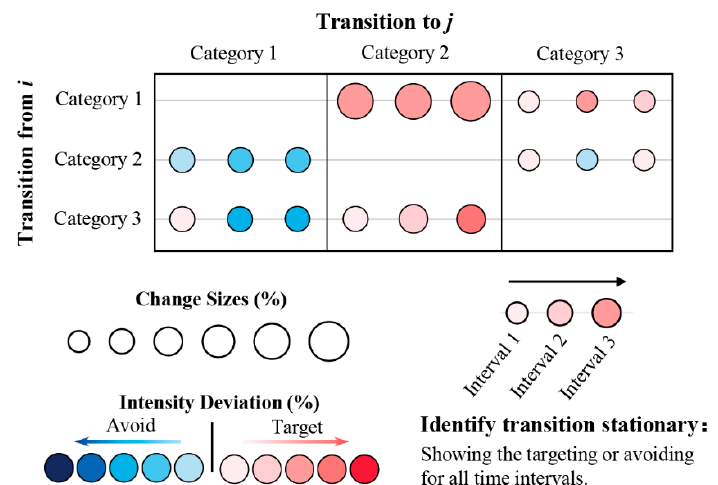
Figure 4. Schematic diagram of transition pattern.